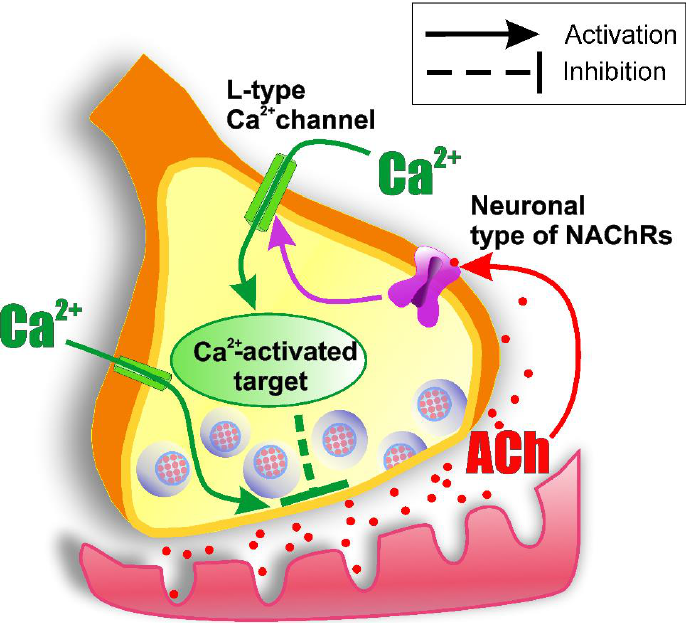
Figure 10. Working model of the mechanism of autoregulation of ACh release in the peripheral cholinergic synapse via nNAChRs. Activation of nNAChRs is accompanied by an increase in the entry of calcium ions into the motor nerve terminal through the L-type (Ca v 1) calcium channels. The latter are involved in both the process of evoked ACh release and its modulation.